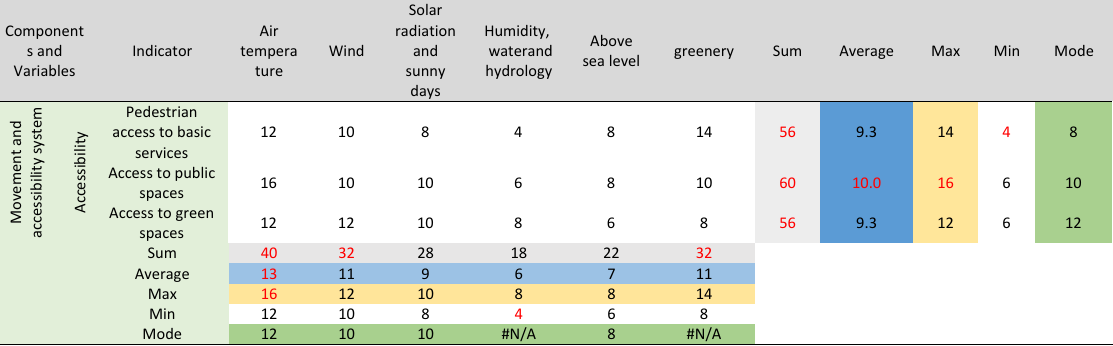
Table 7: Relation between movement and accessibility system and climate indicators